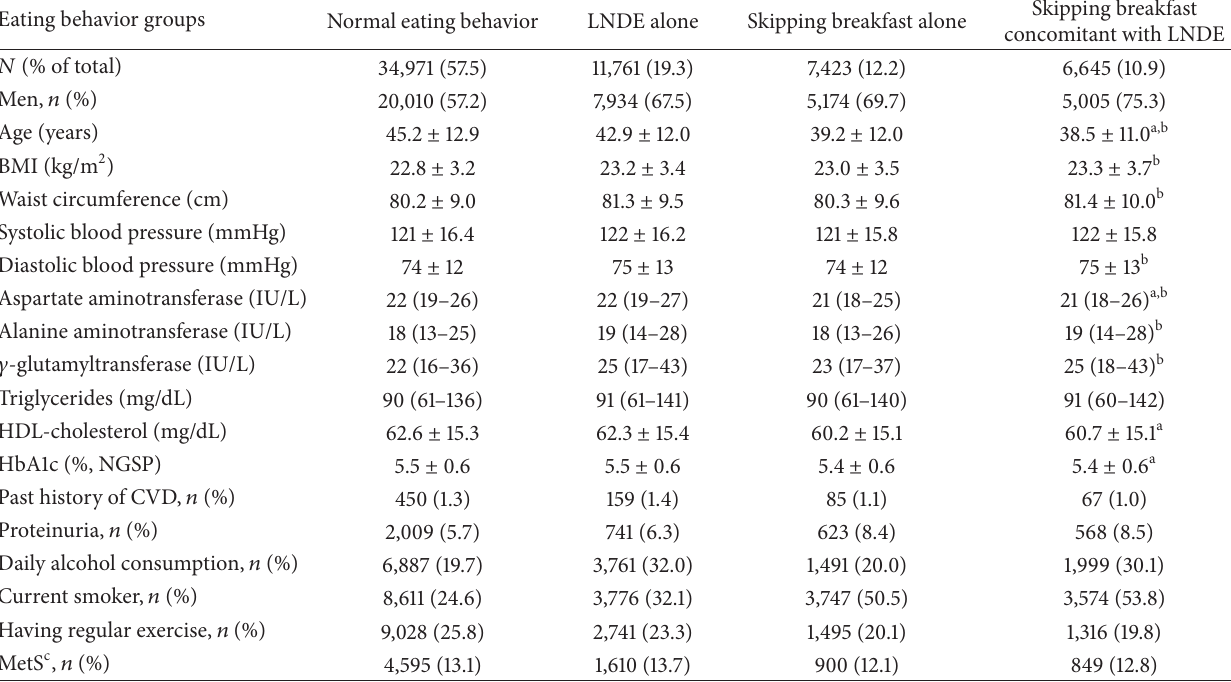
Table 1: Clinical characteristics of subjects according to four eating behavior